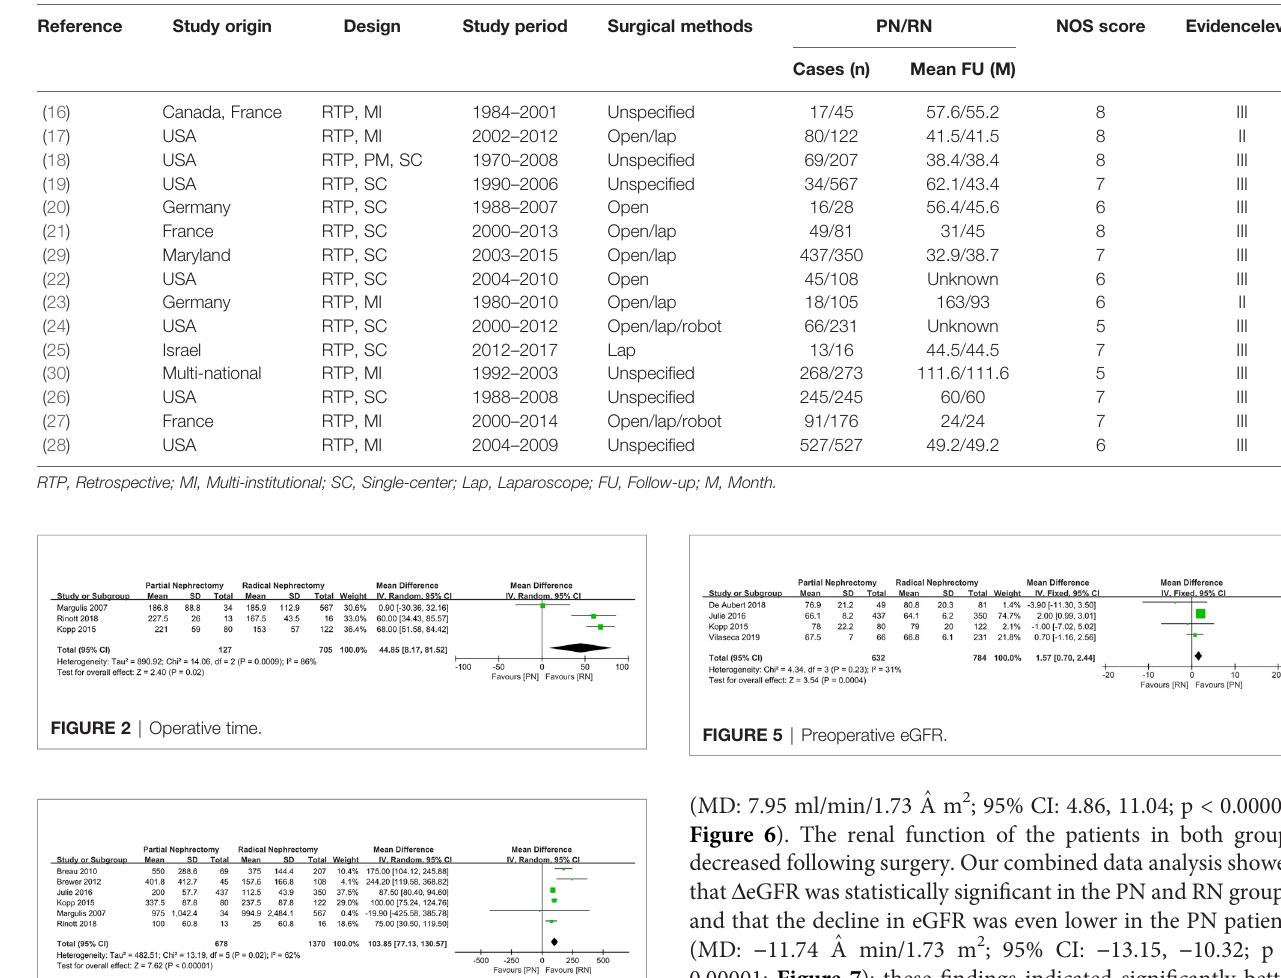
TABLE 1 | Characteristics of the included studies.